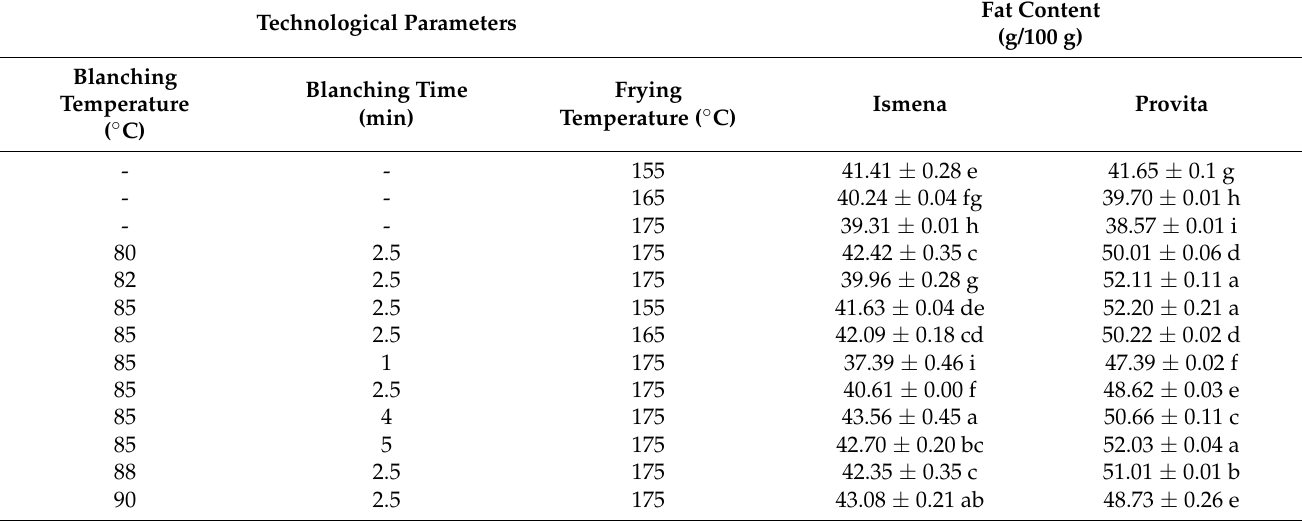
Table 2. Fat content in potato crisps, depending on technological